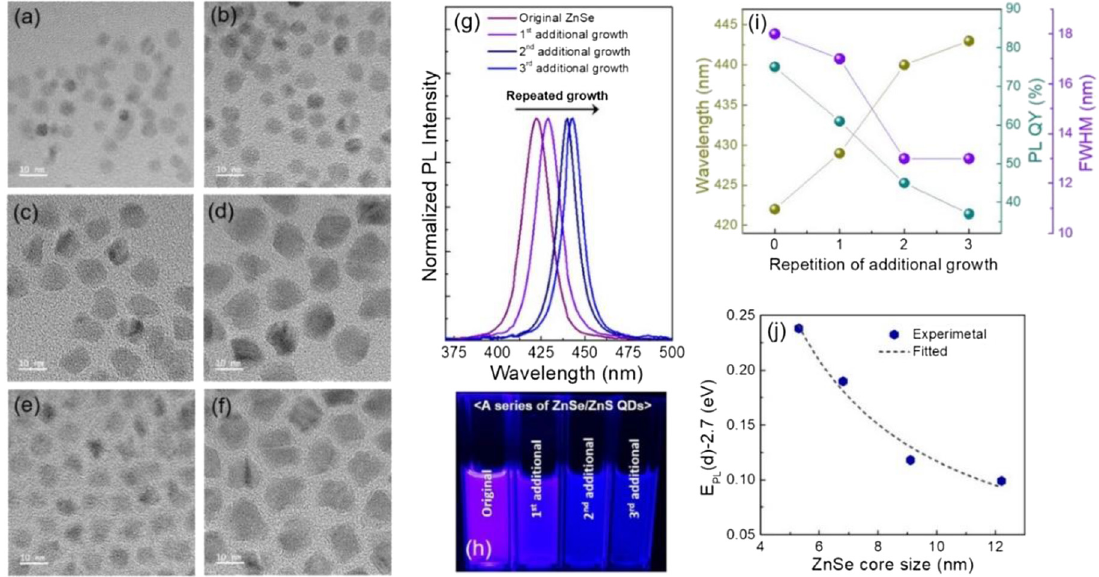
Figure5: TEMimagesof(a)original,(b) fi rst,(c)second,and(d)thirdadditionallygrownZnSecoreQDs,ZnS-shelledQDswith(e)originaland (f) second additionally grown ZnSe cores. The scale bars are 10 nm for all. (g) Normalized PL spectra and (h) hand-held UV lamp-irradiated fl uorescentimagesofaseriesofZnS-shelledcore/shellQDsproducedwithdifferent-sizedZnSecores.(i)VariationsinPLwavelength,QY,and fwhm of ZnSe/ZnS QDs with the repetition of additional core growth (j) Experimental results of ZnSe core size versus PL peak energy of ZnSe/ ZnS QDs and their fi tting result expressed in a power law relation of EPL( d ) − 2.7 = 1.60/ d